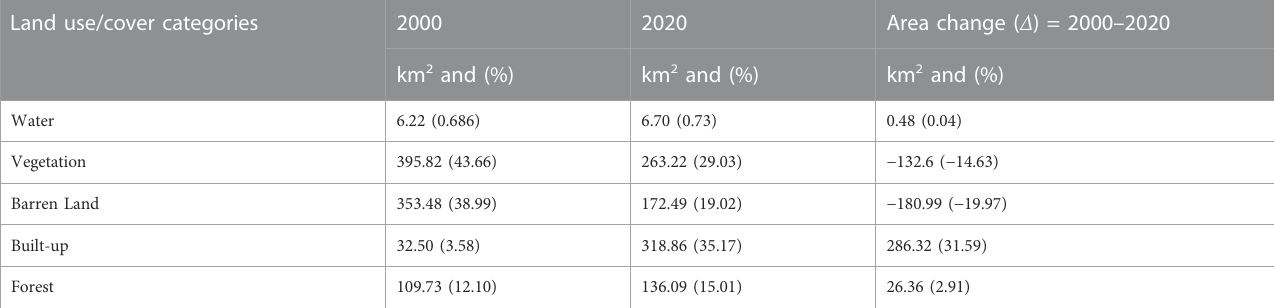
TABLE 3 Area and amount of change in different LULC categories in the study area from 2000 to 2020. Land use/cover